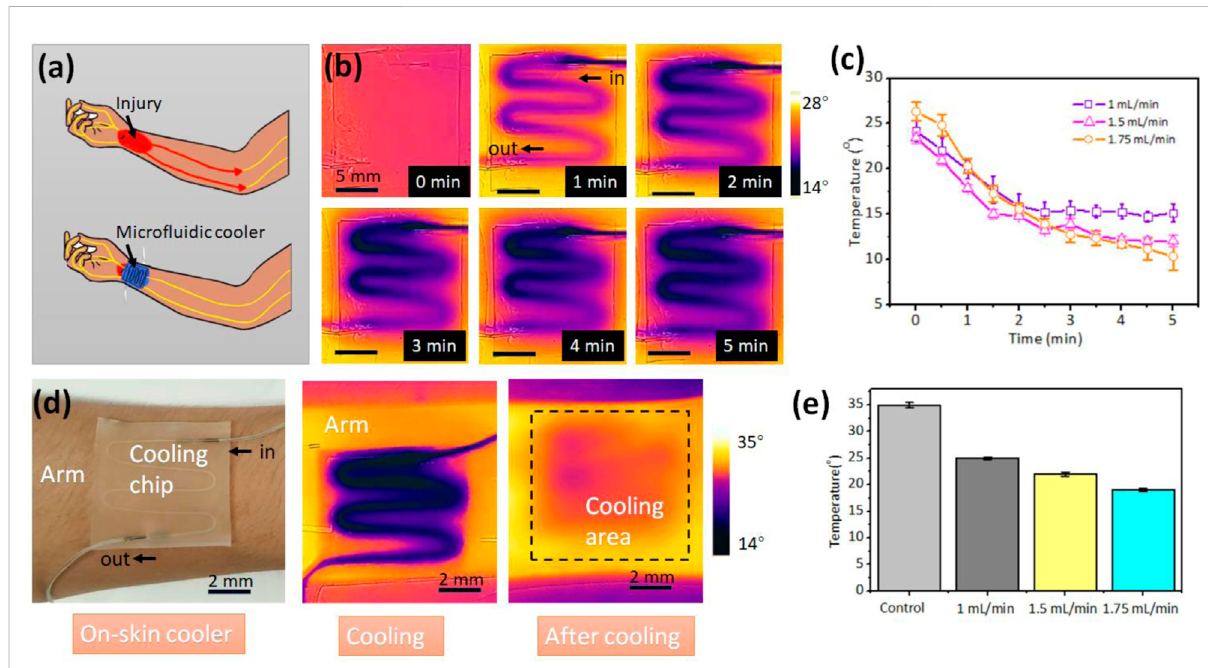
Wearable micro fl uidic cooler. (A) Schematic of the micro fl uidic cooler that can block the peripheral nerve activity during the pain relief. (B) Infrared thermal images of the micro fl uidic cooler. (C) The relationship between fl ow rate of the cold water and the surface temperature of the cooler. The obtained temperature is the average temperature by analyzing the infrared thermal images. (D) The micro fl uidic cooler sticking on the human arm for local cooling. (E) The skin temperatures at the various fl ow rate of cold